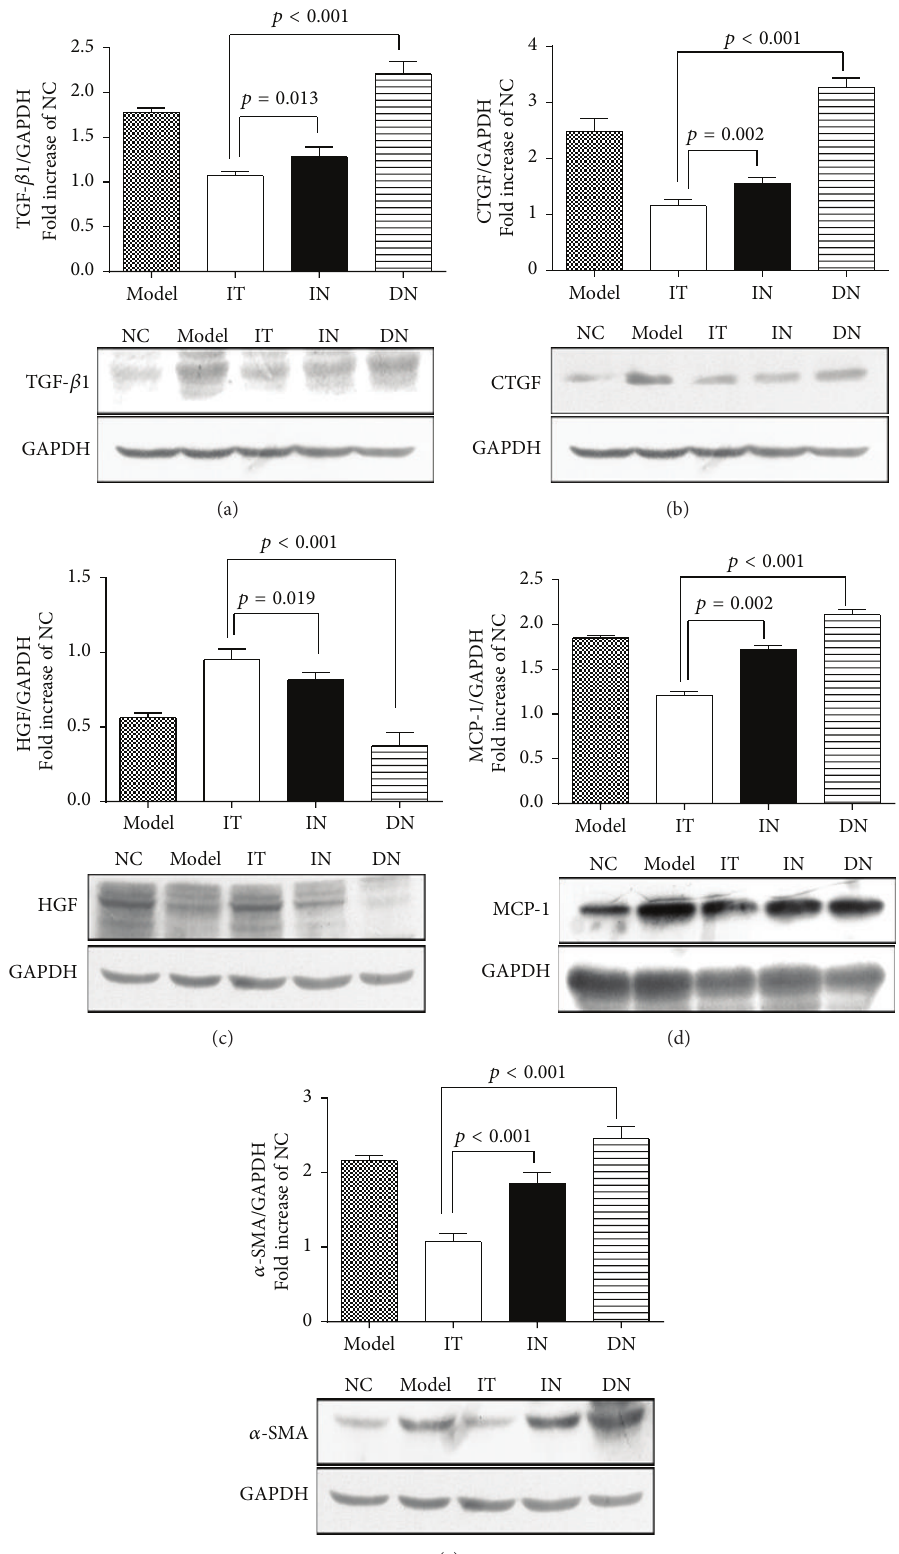
Figure 6: Western blotting analysis of fibrogenic and interstitial fibrosis factors in renal tissues. Western blotting analysis was performed to assess the protein expression of fibrogenic and interstitial fibrosis factors in the kidneys in each group. (a) TGF- 𝛽 1. (b) CTGF. (c) HGF. (d) MCP-1. (e) 𝛼 -SMA. Model group: diabetic nephropathy model rats established at 12